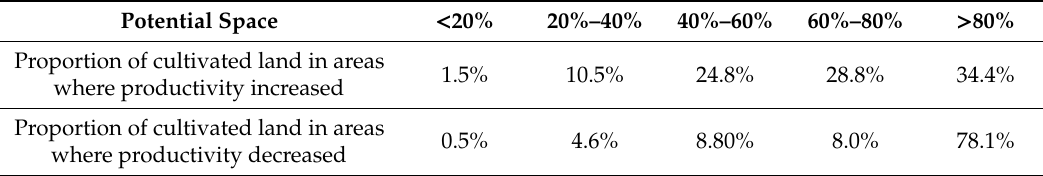
Table 4. Statistics of the potential space of the first crop in productivity changed